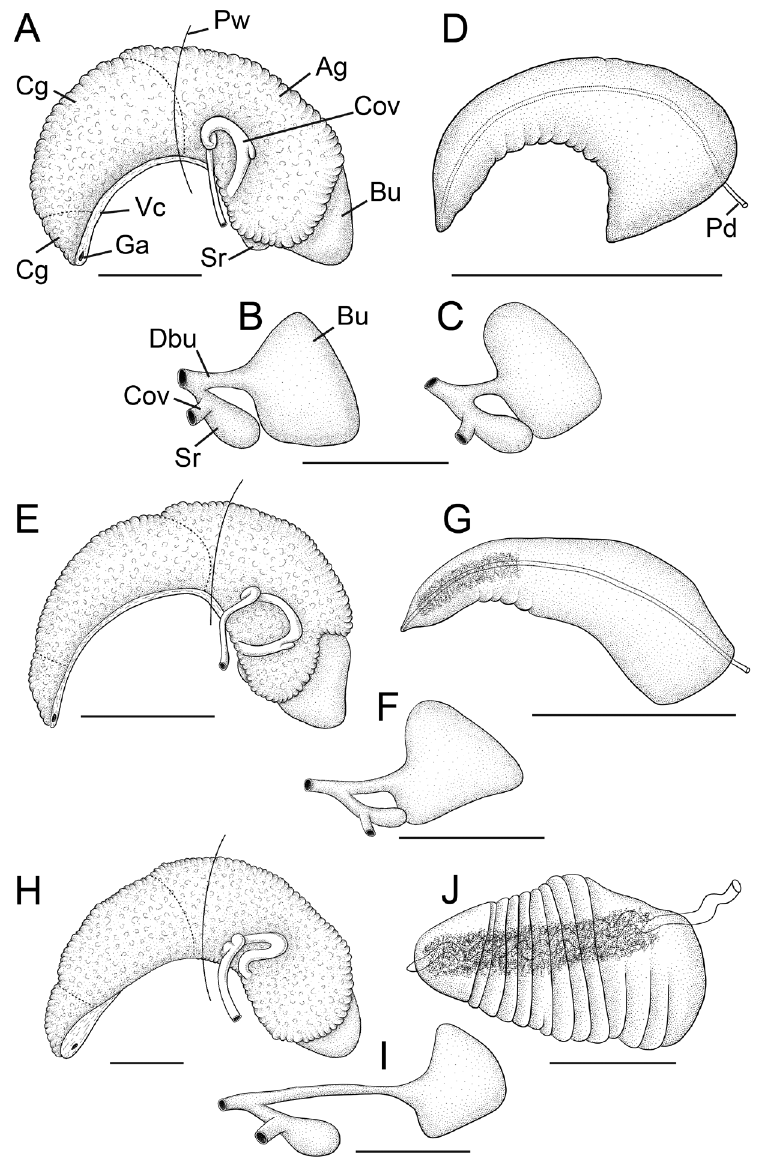
Figure 4. Reproductive anatomy. A–D F. multifarius A, B, D USNM 1144567, C USNM 1070753 E–G F. fresti , sp.n., USNM 1422223 H–J F. umpquaensis , sp. n., USNM 1144736. A, E, G Female glandular oviduct and associated structures (viewed from left side) B, C, F, I Bursa copulatrix and semi- nal receptacle, D, G, J Penis, dorsal surface. The bursa copulatrix and seminal receptacle of type mate- rial of F. multifarius ( C ), which was not illustrated by Hershler et al. (2007), is shown for comparative purposes. Scale bars, 500 µm. Ag albumen gland Bu bursa copulatrix Cg capsule gland Cov coiled oviduct Dsr seminal receptacle duct Ga genital aperture Pd penial duct Pw posterior wall of pallial cavity Sr seminal receptacle Vc ventral channel of capsule